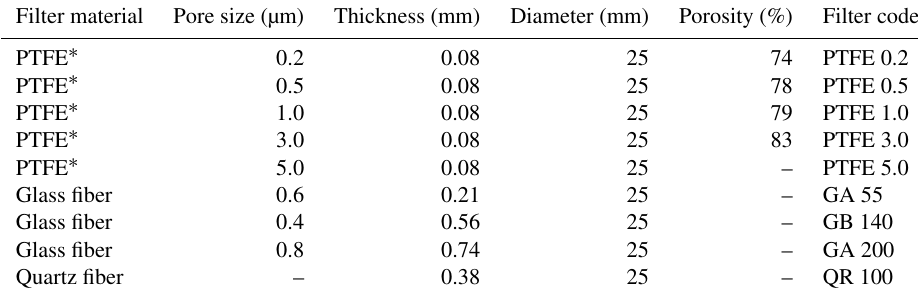
Table 1. Specifications of tested particulate filters with abbreviations.